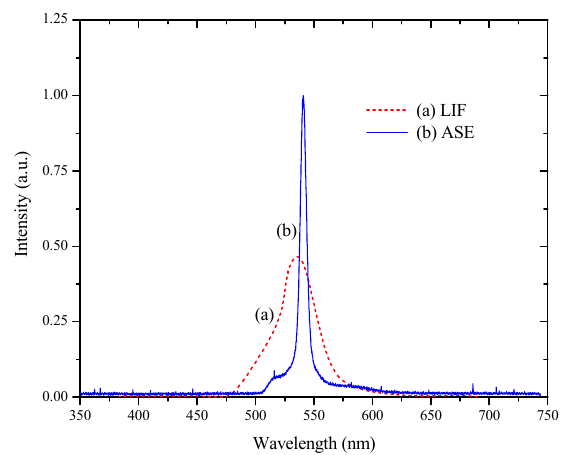
Figure 4. ( a ) Laser induced fluorescence (LIF) for high concentration (1 µM) at low pump power (1 mJ) and ( b ) amplified spontaneous emission (ASE) for the same concentration at 2.3 mJ pump power.